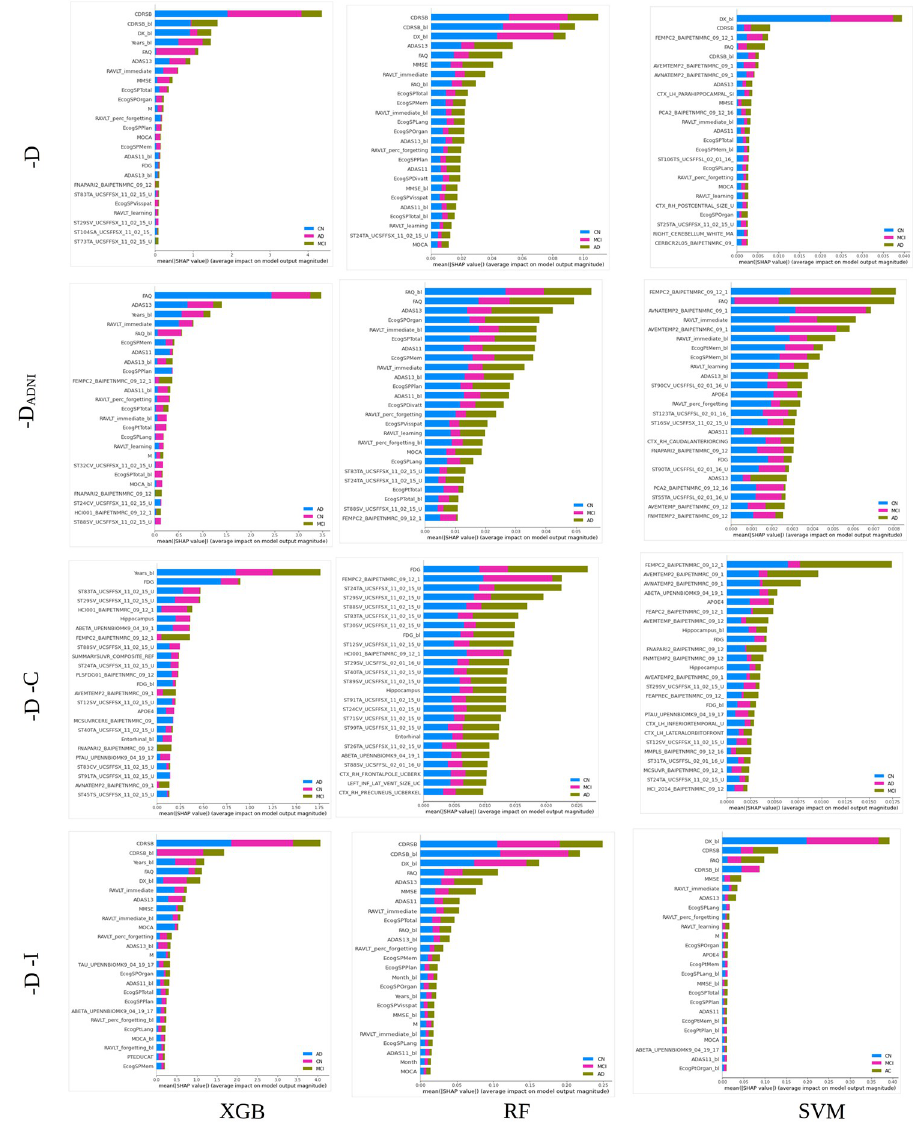
Fig 8. Mean absolute SHAP values computed from the XGB, RF, and SVM systems with feature ablation. First and second rows: models trained after removing diagnosis (-D) and features used in ADNI for diagnosis (-D-D ADNI ). Third and fourth rows: models trained after removing cognitive (-D-C) and image-based (-D-I) features. Note that the label coloring is not consistent among experiments owing to rigid SHAP implementation. Long feature names have been trimmed for better